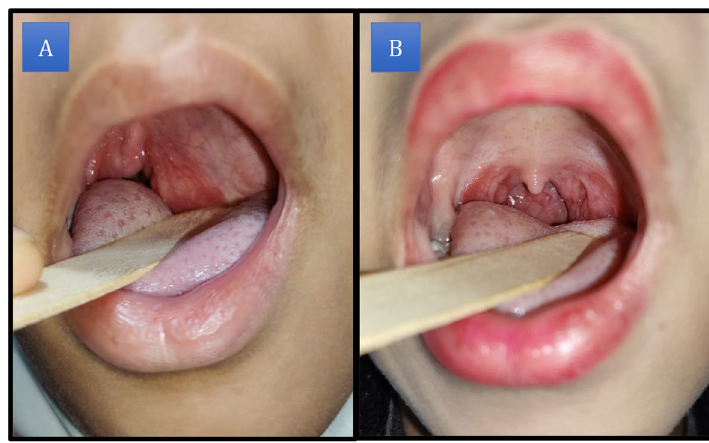
Fig. 1 Oral examination showing buldge in the left oropharynx preoperatively A , and normal postoperative picture B